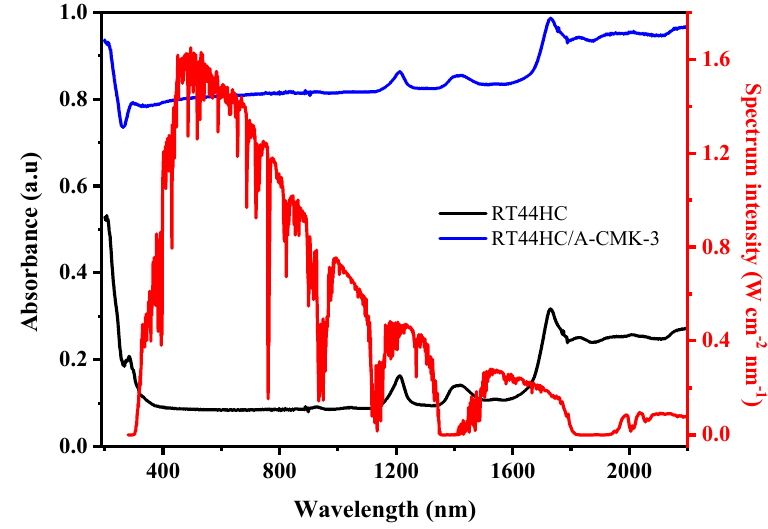
Figure 11. Optical absorptive property of A-CMK-3 based PCM.